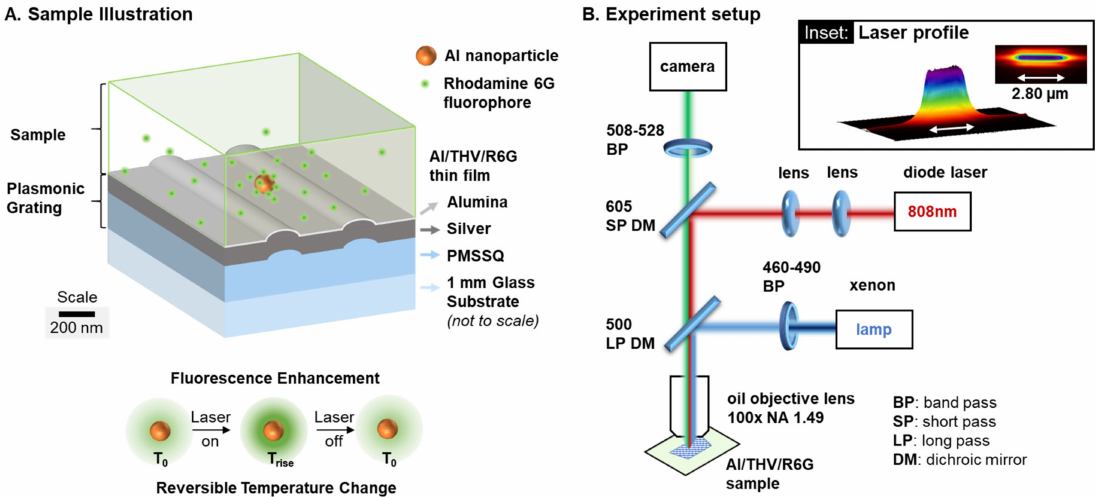
Figure 1. ( A ) Schematic of an energetic nanocomposite thin film deposited on a plasmonic grating substrate and ( B ) Schematic of experimental setup for in situ photothermal heating of a single nanoparticle in fluorescence-temperature measurement incorporating laser, microscope, and camera systems. (Inset) Laser profile as focused to deliver energy specifically to the aluminum nanoparticles (Al